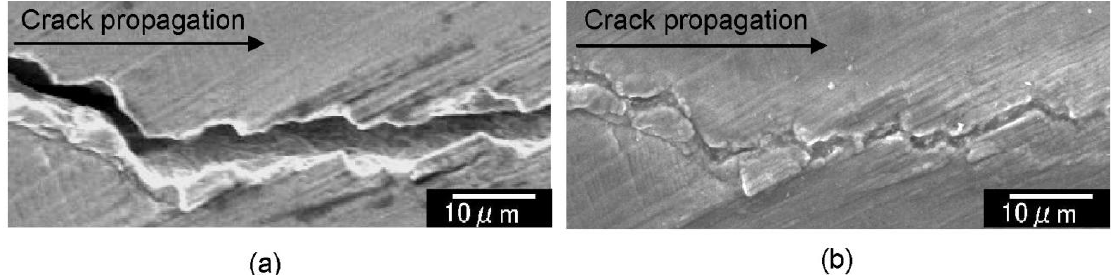
Figure 6. Magnified images of fatigue cracks in Figure 5: ( a ) before and ( b ) after 35 applications of electropulsing.